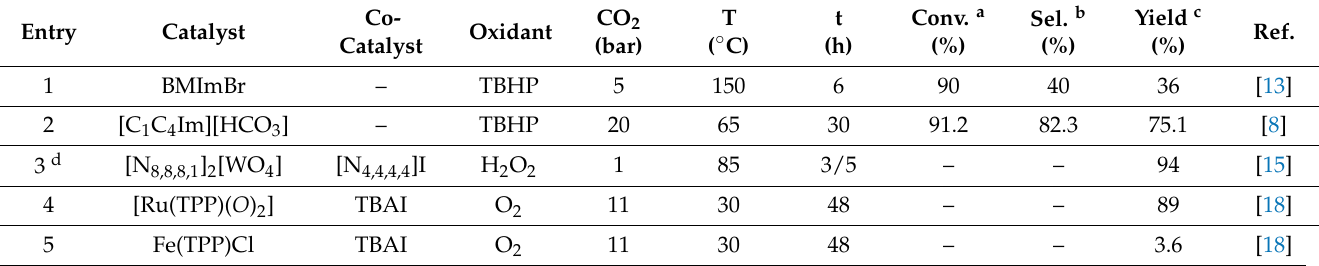
Table 1. The direct oxidative carboxylation of olefins catalyzed by the homogeneous catalytic sys ‐ tem.